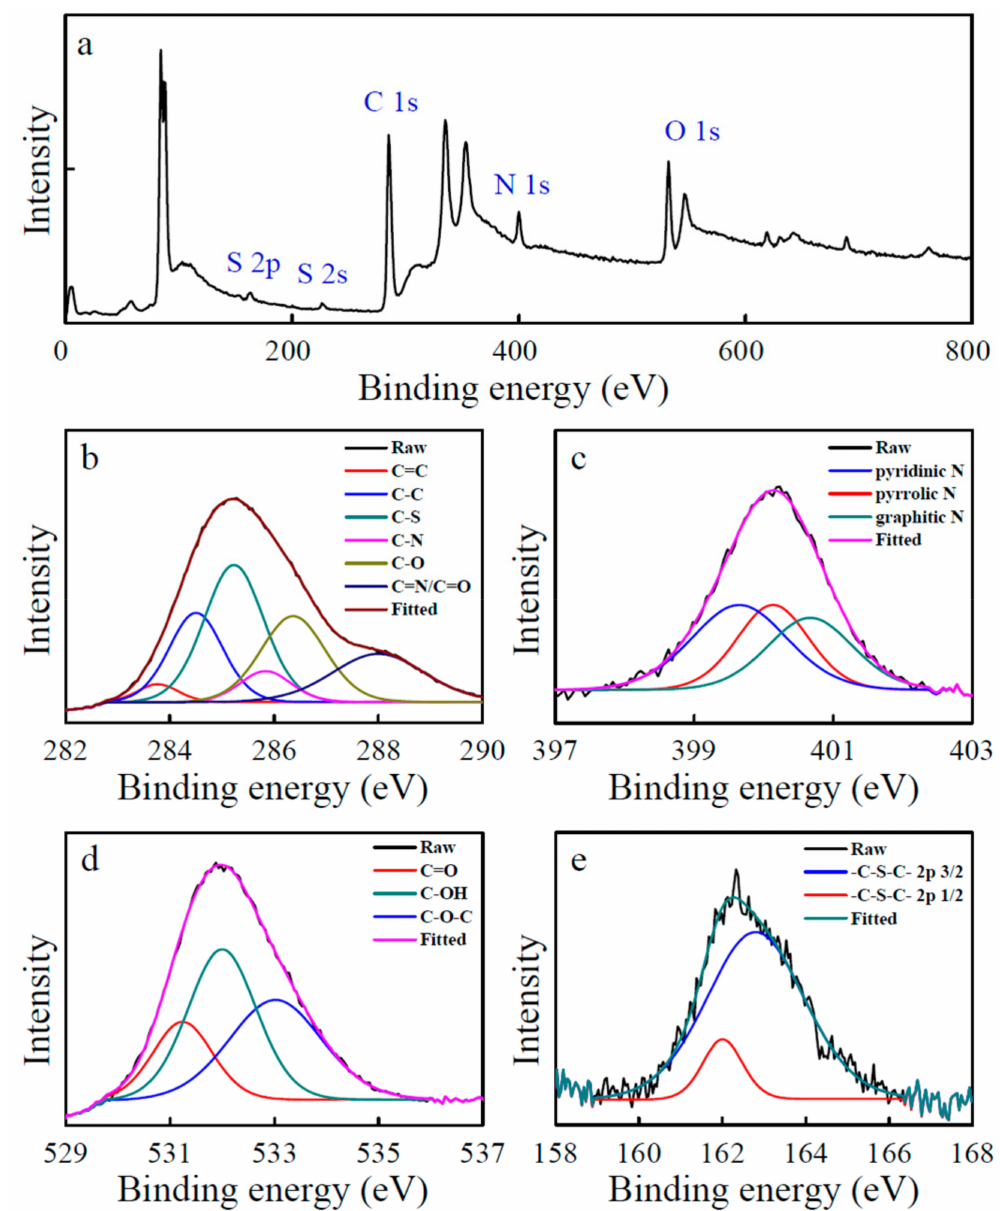
Figure 3. XPS spectra of the CDs: ( a ) Full-scan XPS spectrum. High-resolution XPS spectra of ( b ) C 1s, ( c ) N 1s, ( d ) O 1s, and ( e ) S